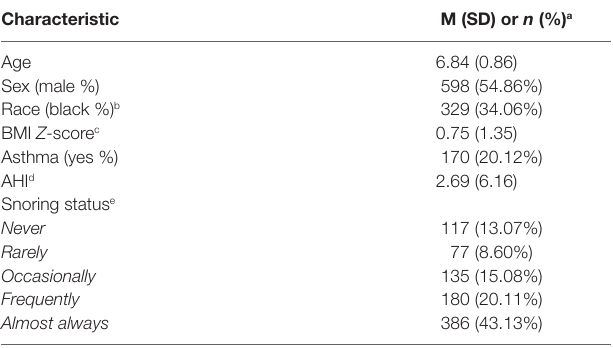
TaBle 1 | Cohort demographic characteristics ( N = 1,116 a